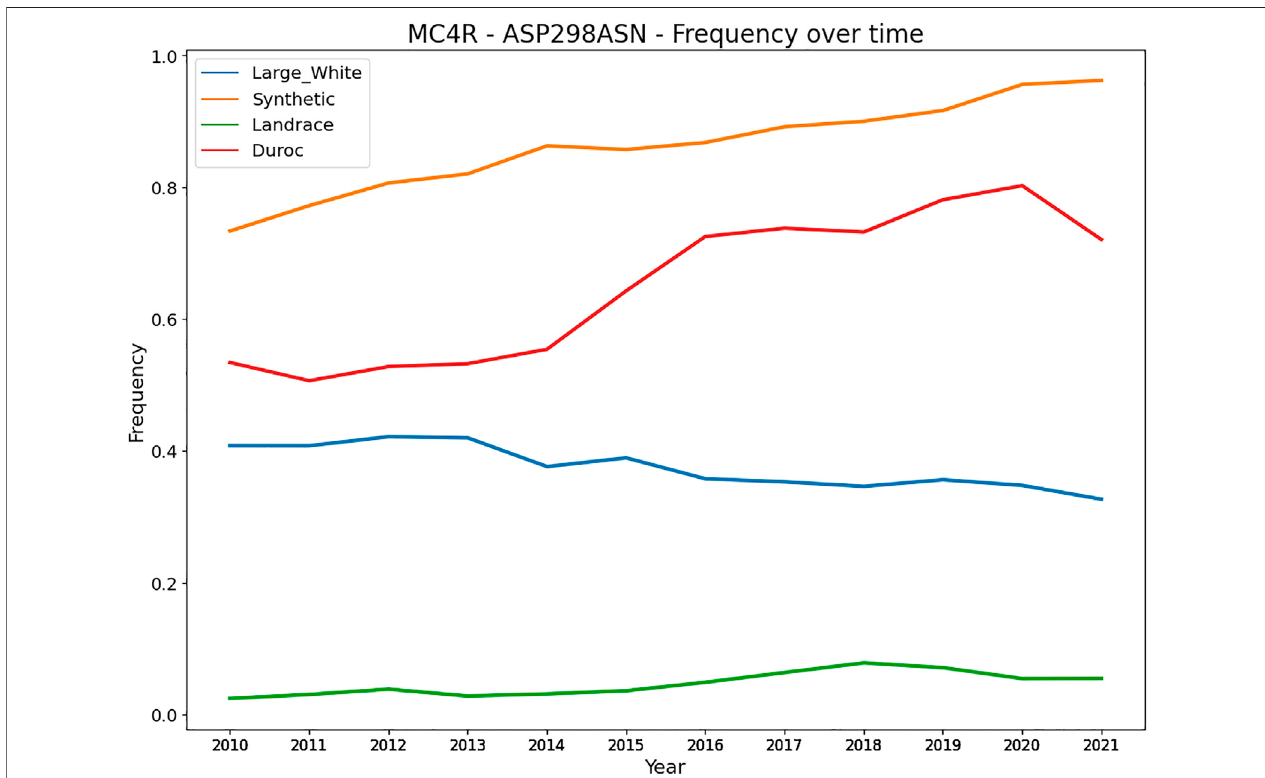
FIGURE 5 | Frequency of the MC4R - Asn298 allele in four commercial pig breeds from Topigs Norsvin. The Asn298 allele is associated with more fat, higher feed consumption and faster growth, while the Asp298 allele is associated with less backfat, slower growth, and lower feed intake (Kim et al., 2000).